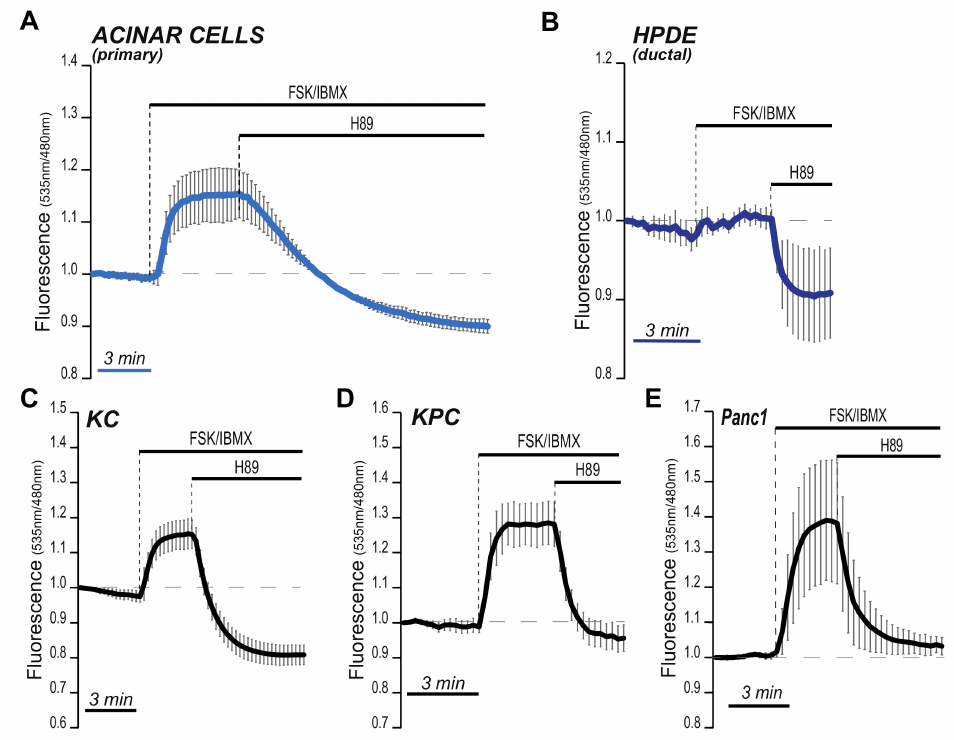
Figure 4. Stage-specific PKA activity in pancreatic cancer cells. Pancreatic epithelial cells (non transformed, ductal and acinar, and tumoral, indicated at the top of each panel) were infected with adenoviral vectors encoding for the PKA sensor AKAR4 and imaged after 36 h. Fluorescence intesities were recorded for several minutes, before and after the addition of indicated compounds. The graphs show FRET ratios over time. Scale bars, 3 min. In ( A ), mouse-derived primary acinar cells; in ( B ), normal duct cells (commercially-available; HPDE); in ( C ), primary mouse cells derived from bona fide pre-malignant lesions (PanIN); in ( D , E ), PDA tumor cells, both primary (mouse-derived) and from an established human cell line (Panc1). Graphs are representative of three independent